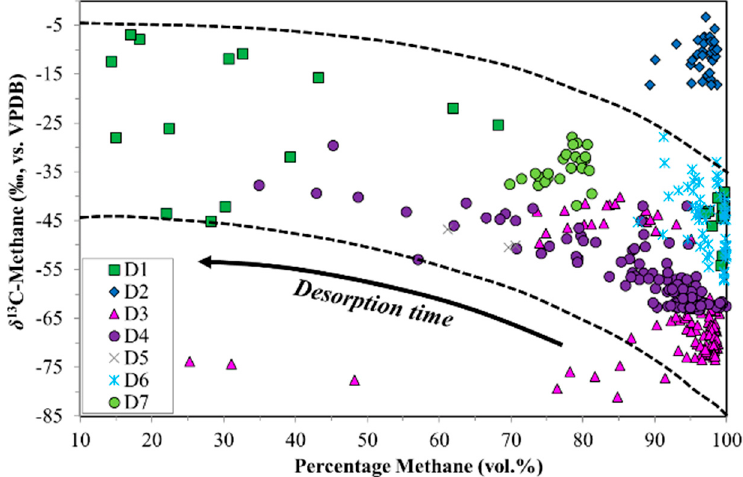
Figure 6. δ 13 C-CH 4 ratios from coalbed methane (CBM) desorption experiments versus % methane.